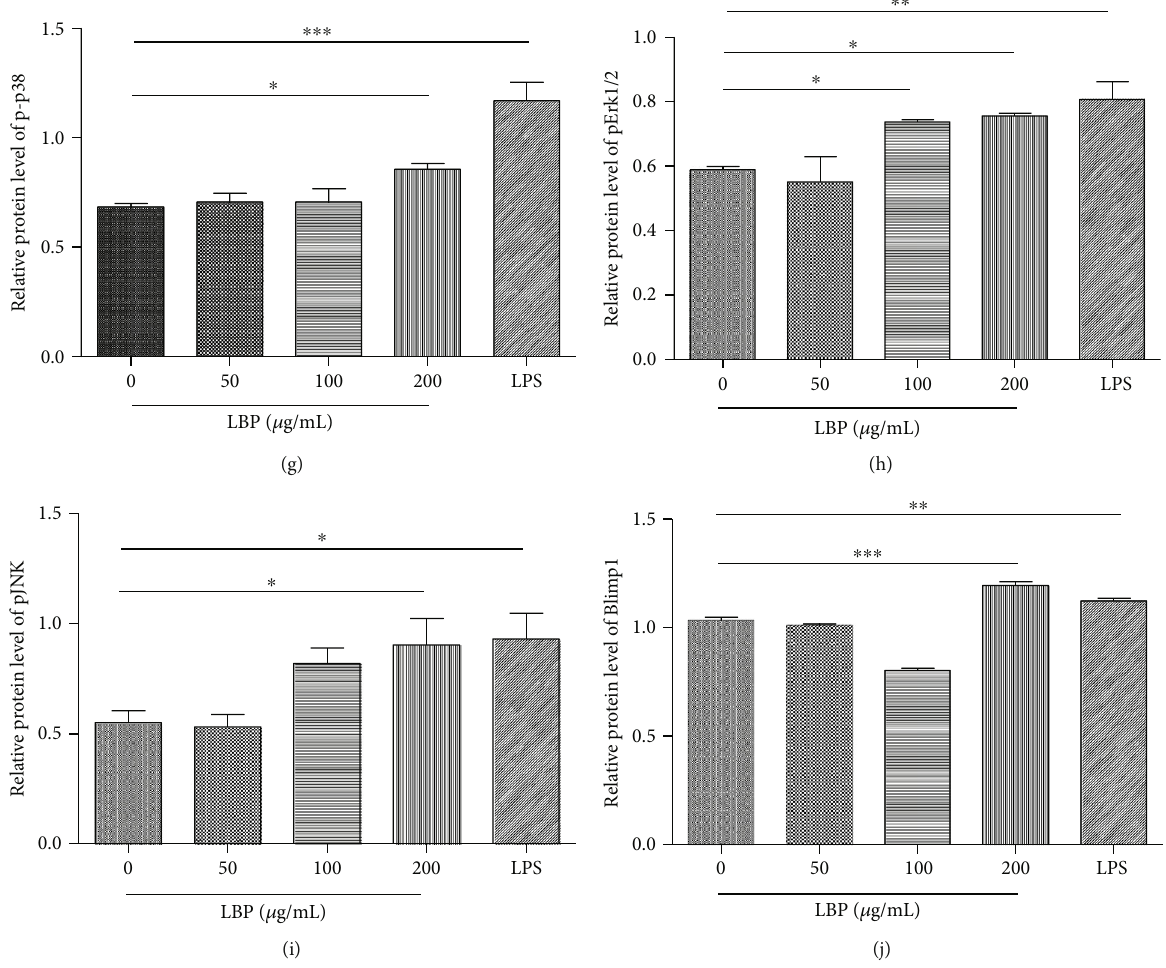
Figure 3: LBP increase MAPK, Blimp1 mRNA, and protein expression in DCs. DCs were stimulated for 30 min with LBP (0, 50, 100, and 200 μ g/mL) and LPS (100ng/mL), respectively. After stimulation, the mRNA and protein expressions were checked as p38 (a), Erk1 (b), Erk2 (c), JNK (d), Blimp1 (e), p38 (g), Erk1/2 (h), JNK (i), and Blimp1 (j). Values are the mean and SD of 3 independent experiments. ∗ P < 0 : 05 , ∗∗ P < 0 : 01 , and ∗∗∗ P < 0 : 001 versus (Figure 3(d)), Blimp1 (Figure 3(e)), phospho-p38 (Figure 3(g)), phospho-Erk1/2 (Figure 3(h)), phospho- MAPK/JNK (Figure 3(i)), and Blimp1 (Figure 3(j)). We found that mRNA and protein expression of these molecules was signi fi cantly increased, respectively, after stimulation with LBP (200 μ g/mL) for 30 min. These results indicate that LBP can regulate the expression of TLR4 downstream molecules p38, Erk1/2, JNK, and Blimp1 in DCs.